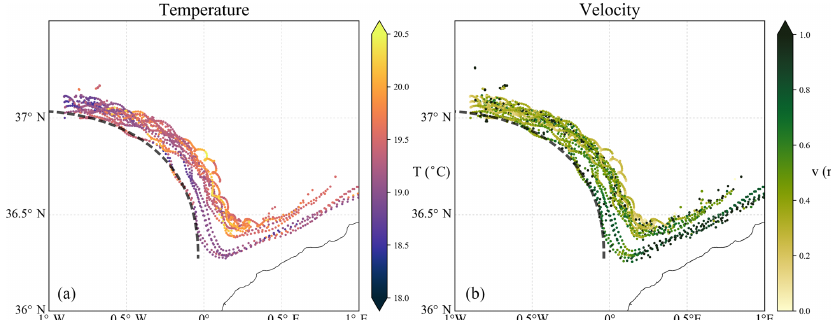
Figure 9. Drifter temperature (a) and velocity (b) in the area of study.